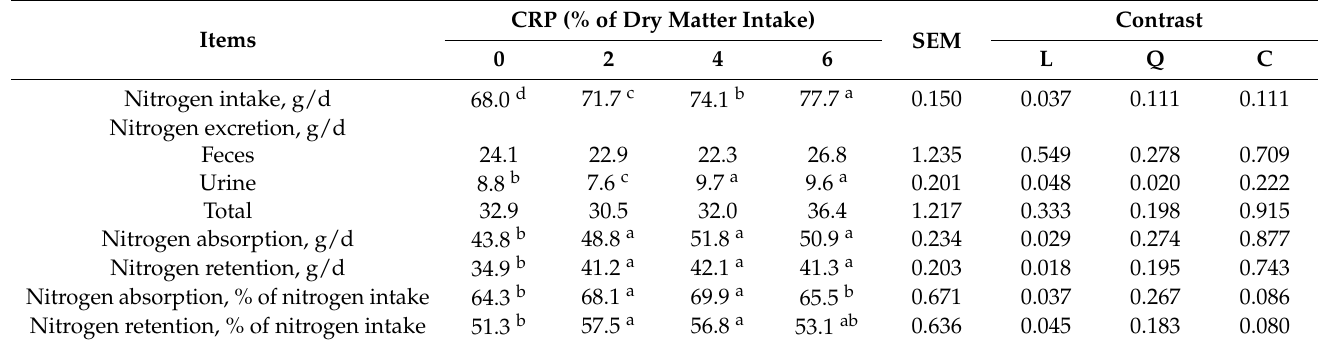
Table 5. Effect of chaya leaf and rambutan peel pellet (CRP) on nitrogen